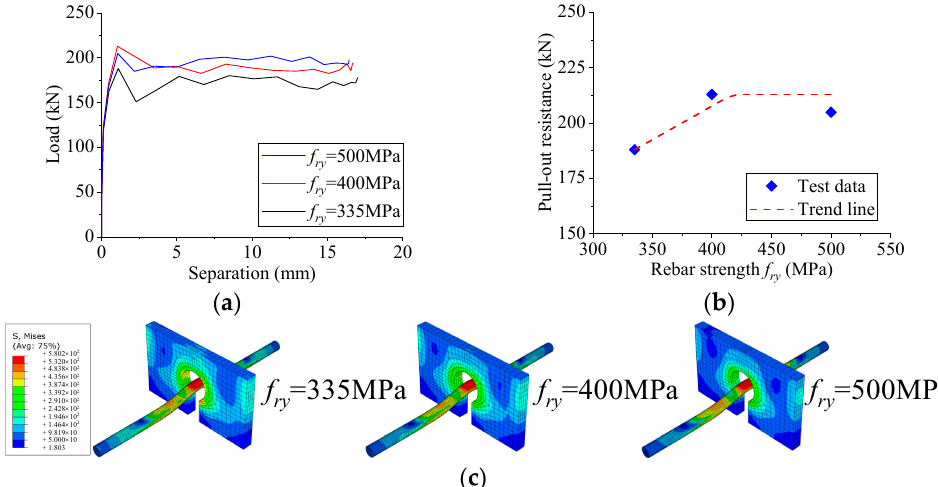
Figure 19. Influence of rebar strength. ( a ) Load–separation curves; ( b ) influence analysis; ( c ) failure mode.